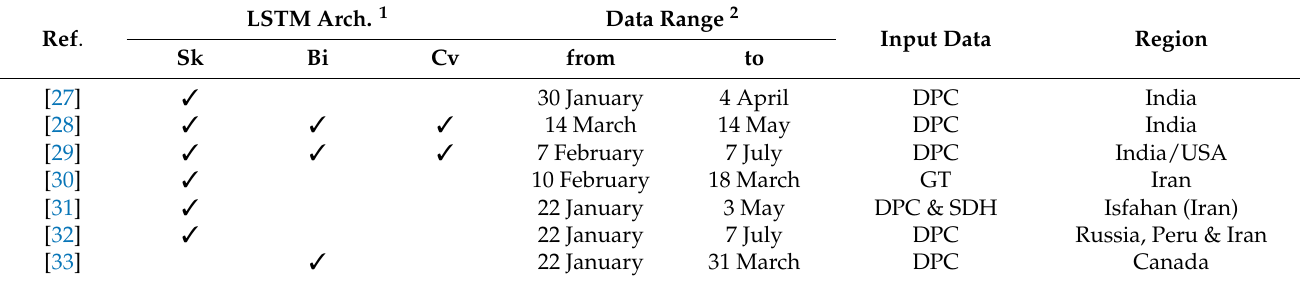
Table 1. Brief list of recent studies that demonstrate the use of LSTM network architectures in forecasting COVID-19 cases. Ref